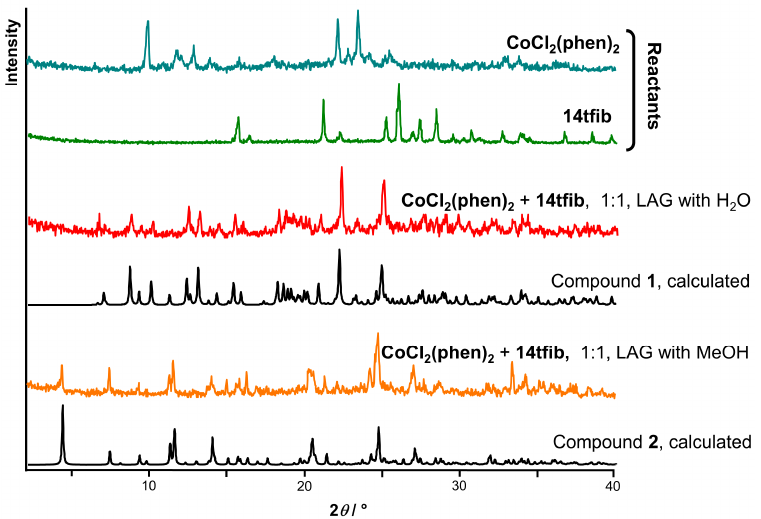
Figure 2. A comparison of the powder diffraction patterns of reactants, LAG products and diffraction patterns calculated from the obtained single crystal data of 1 and 2 .